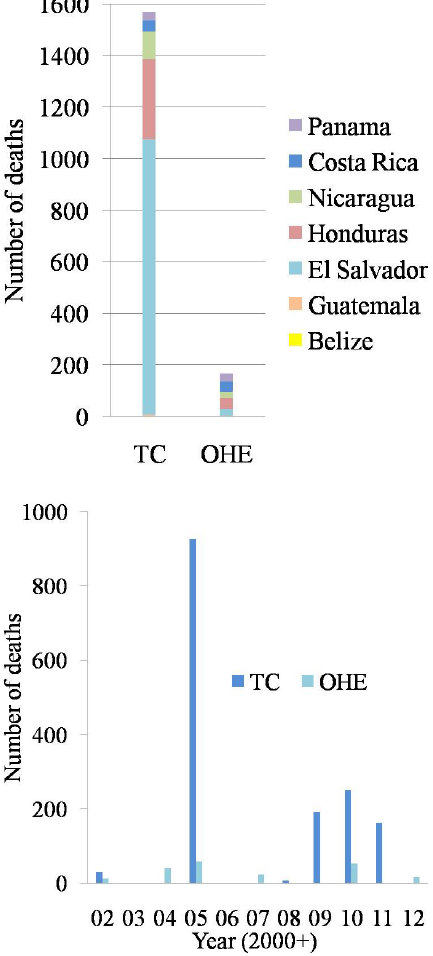
Fig. 4. (a) Number of victims per country due to tropical cyclone activity (TC) and other hydro-meteorological events (OHE) and, (b) number of victims per year due TC and OHE during 2002–2012.